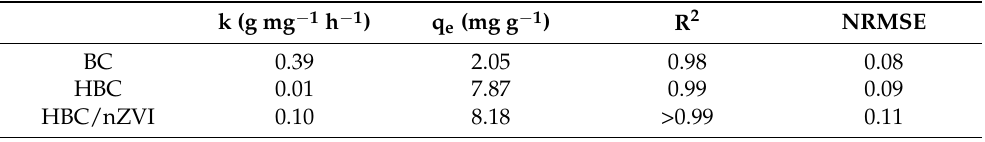
Table 1. Pseudo-second-order kinetic model characteristics for the removal of Cr(VI) using BC, HBC, and HBC/nZVI under an initial Cr(V) concentration = 10 mg L − 1 , pH = 4.0, adsorbent dose = 1.5 g L − 1